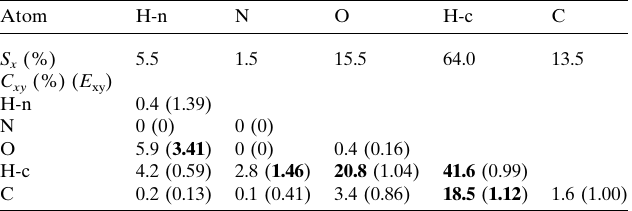
Table 2 Statistical analysis of intermolecular contacts on the Hirshfeld surface. H-c and H-n signify hydrogen atoms bound to C (hydrophobic) and N (hydrophilic), respectively. Reciprocal contacts ( X (cid:2)(cid:2)(cid:2) Y and Y (cid:2)(cid:2)(cid:2) X ) are merged. The most prevalent and enriched contacts are highlighted in bold.